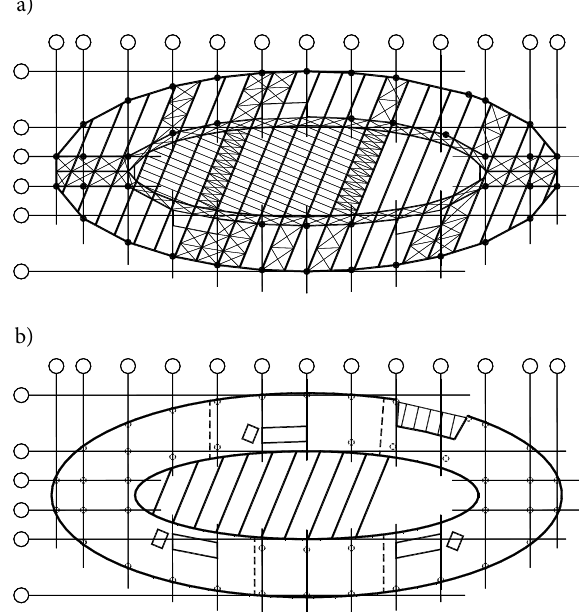
Fig. 5. A principal scheme of the roof: steel structures, initial and “A” revisions of the technical project (a); post-tensioned concrete structure, revision “B” of the technical project